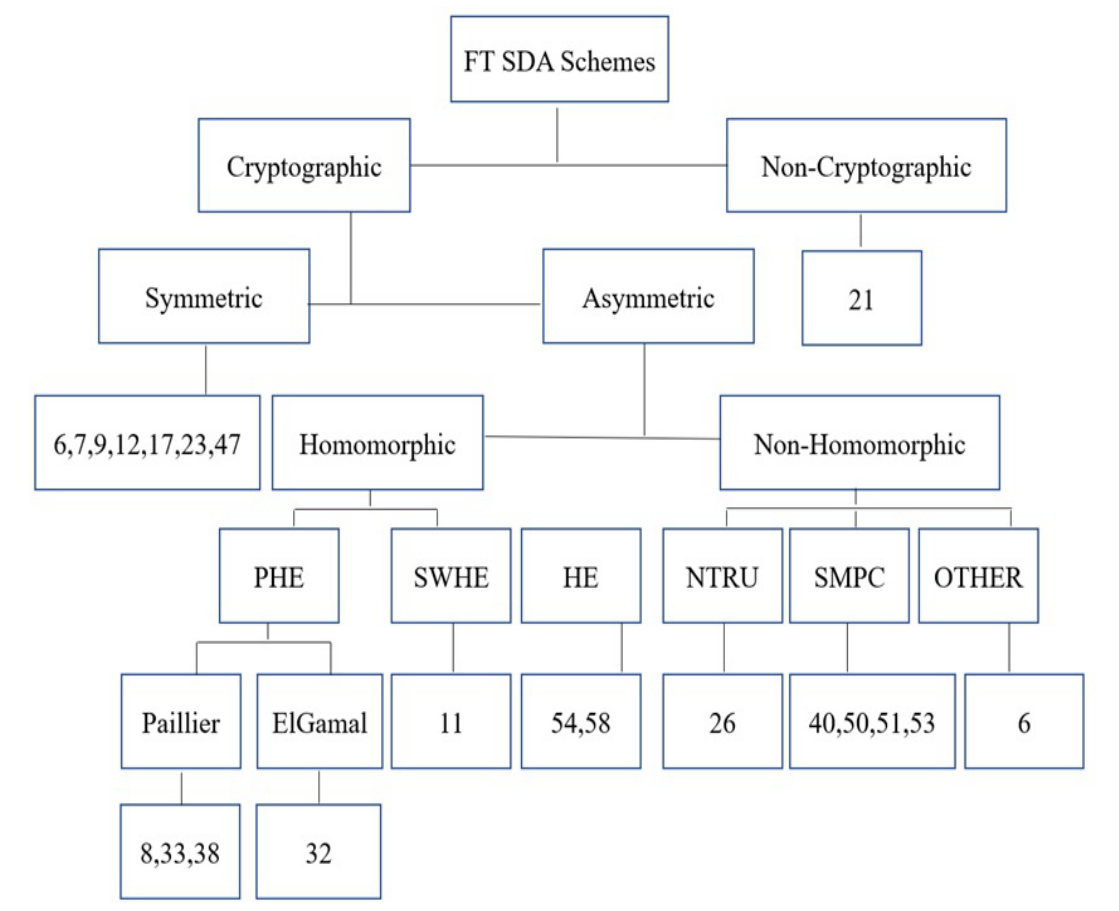
Figure 3. Taxonomy of FTSDA schemes in smart